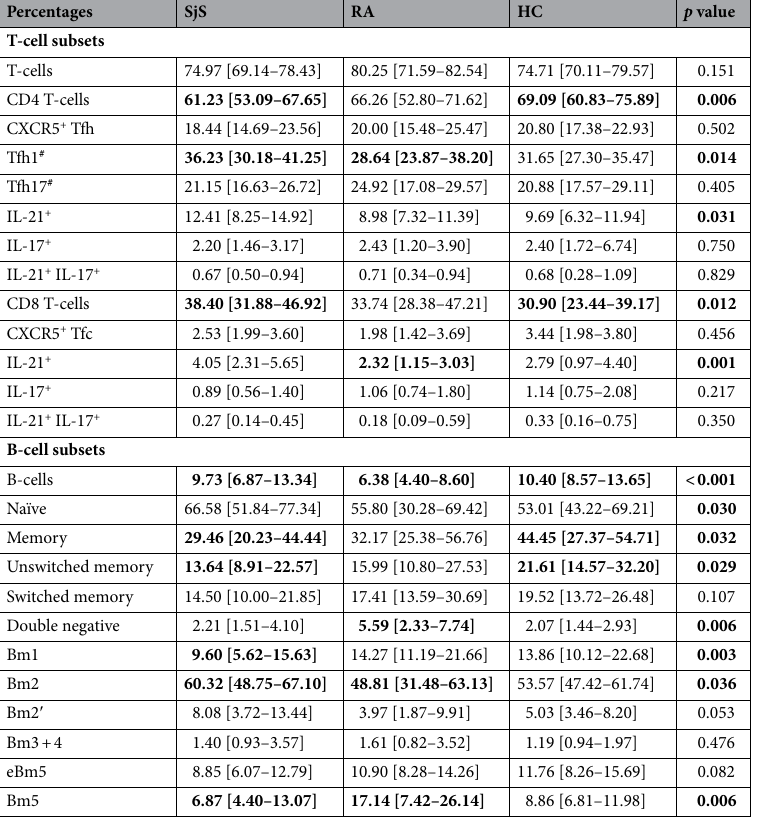
Table 1. Percentages of T and B-cell subsets in all groups. T and B cells subsets’ percentages presented in mean ± standard deviation. Bold numbers highlight the populations that were significantly different. Kruskal– Wallis test was applied for statistical significance. # Tfh1 and Tfh17 are represented as percentages among